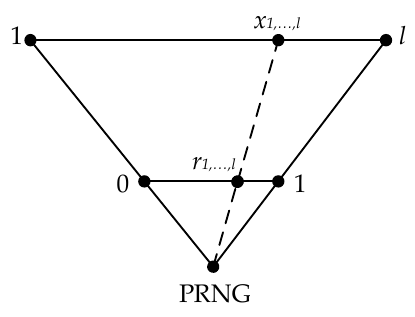
( ) r 0;1 into from the range  1, , l